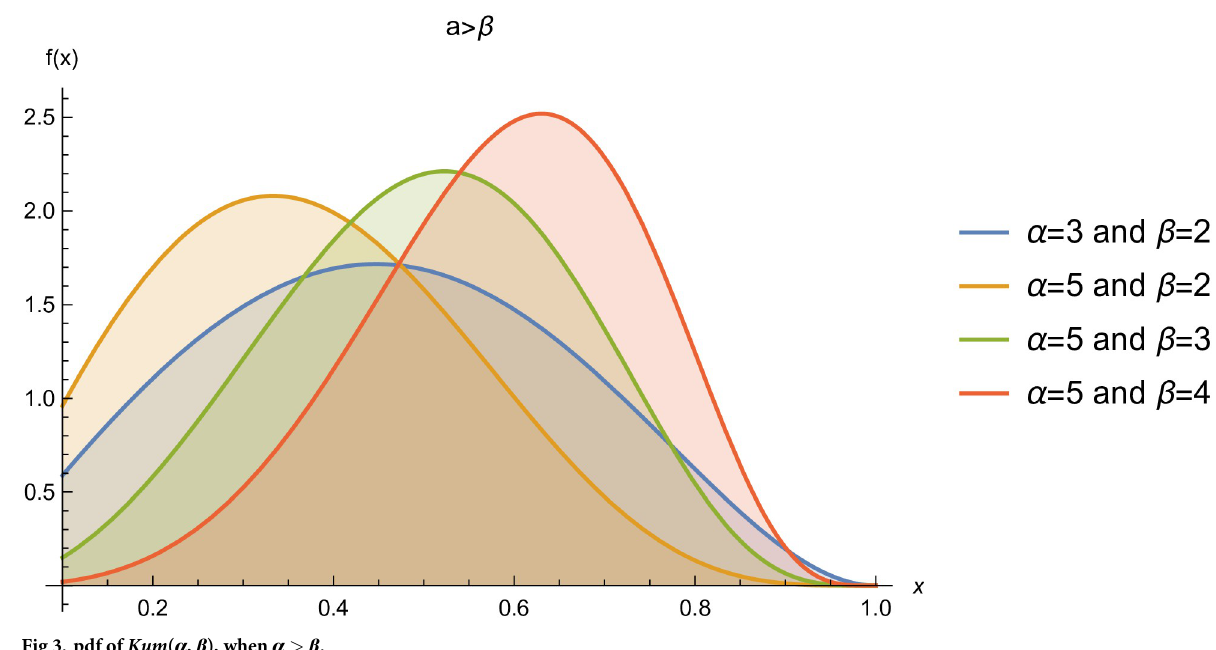
Fig 3. pdf of Kum ( α , β ), when α > β .